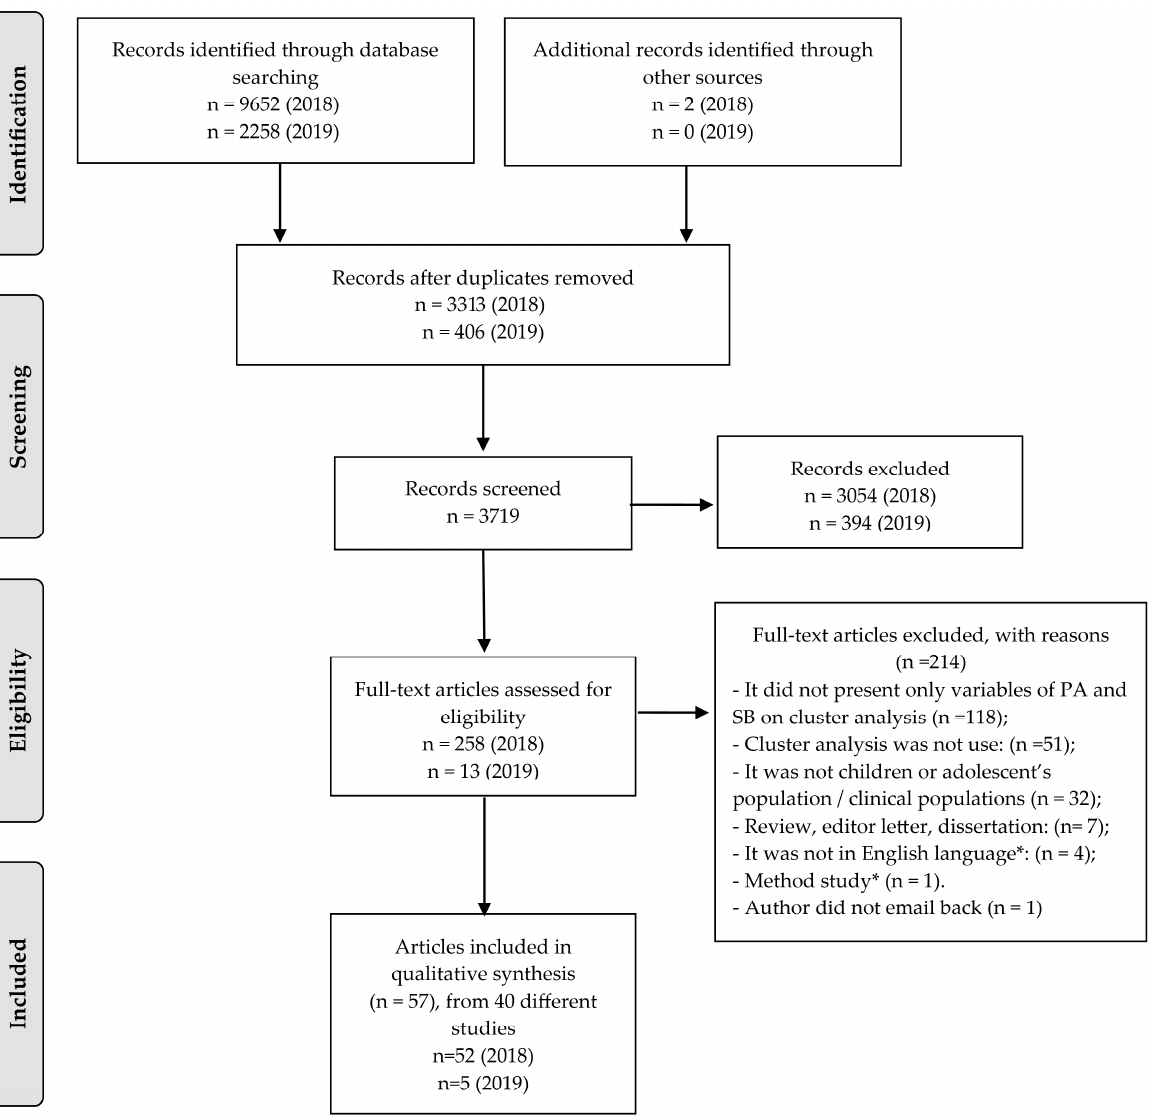
Figure 1. Flowchart of studies selection procedure in accordance to PRISMA flow diagram. * French ( n = 1), German ( n = 1), and Polish languages ( n = 2). * Explained how to use cluster analysis—did not present original findings. PA: physical